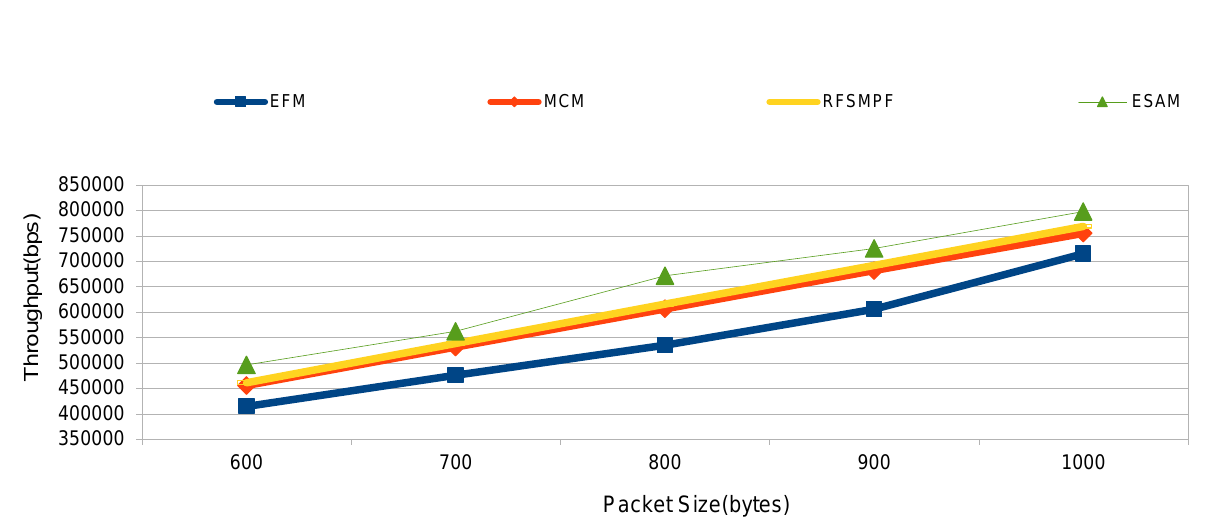
Figure 10 . Packet Delivery Ratio Vs Packet Size